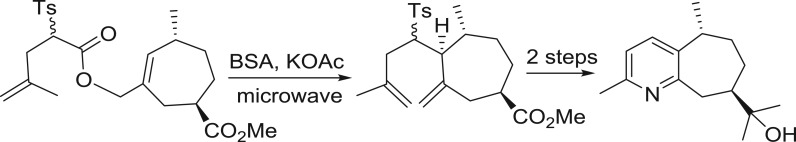
Craig's strategy for synthesis of (+)-cananodine.